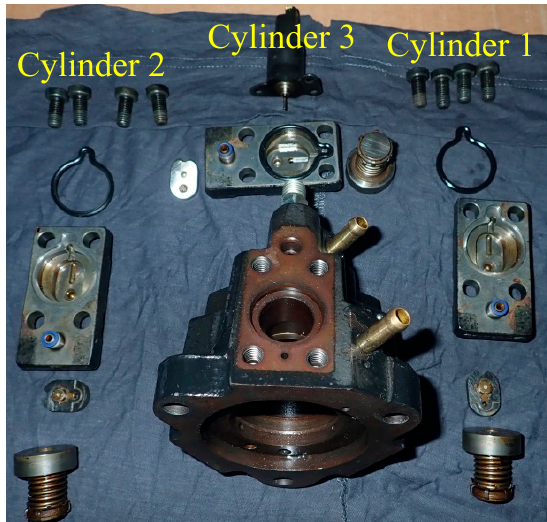
Figure 7. Disassembly view of the Bosch CP1S high-pressure pump, showing components assessed for wear.